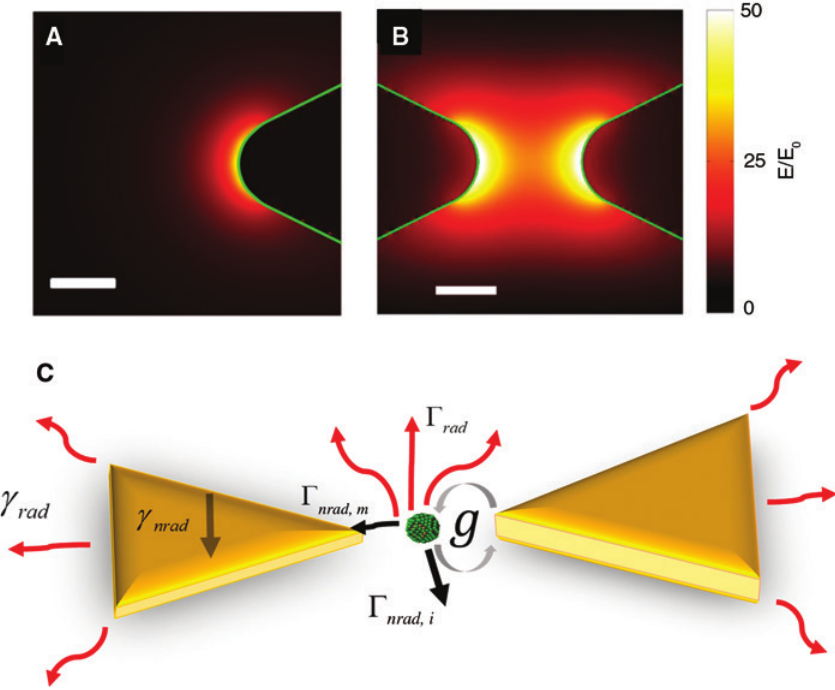
Figure 2: Interacting with a plasmonic cavity. (A, B) Electromagnetic simulation of the electric field enhancement adjacent to a prism PC (A) and at the hotspot of a bowtie PC (B). The white bars represent 10 nm. (C) Schematic illustration of the various decay paths of a QD coupled to bowtie PC. The QD can emit either radiatively ( Γ ) or non-radiatively through intrinsic processes Γ rad plasmon mode which can emit light with a radiation rate γ from Ref.